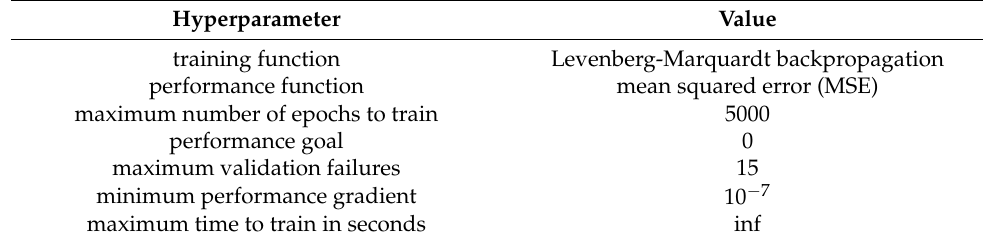
Table 5. Hyperparameters of the MLP training